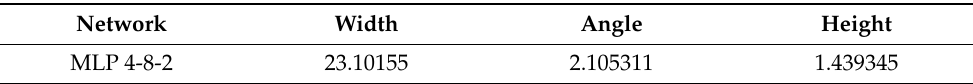
Figure 13. Predicted TE value for the different widths and heights of the initiator. Table 5. Sensitive analysis of geometrical parameters of crush initiators.